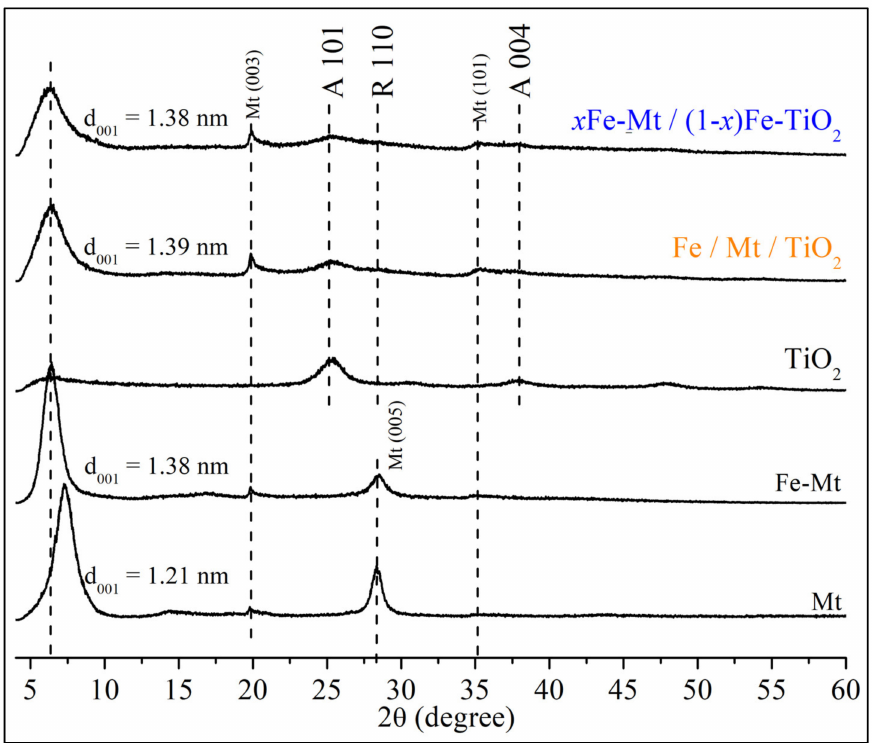
Figure 1. XRD patterns of original Mt, Fe-Mt synthesized at RT, TiO 2 , Fe/Mt/TiO 2 , and x Fe-Mt/(1 − x )Fe-TiO 2 synthesized at 70 ◦ C. The only single anatase phase of TiO 2 was presented for the pristine TiO 2 . For both Fe/Mt/TiO 2 and x Fe-Mt/(1 − x )Fe-TiO 2 , the 101 and 004 peaks at 25.4 and 37.9 ◦ (JCPDS No. 21–1272) of anatase phase were detected. Additionally, the 110 peak of rutile was formed at 28.3 ◦ . The representative 001, 003, and 101 reflection peaks of Mt in the composites were detected at 6.0–6.5, 19.8, and 35.2 ◦ , respectively [43]. The formation of TiO 2 in the composites by different synthetic temperatures was elucidated, and their XRD patterns were presented in Figure S2. Peak separation was utilized to further analyze the XRD patterns in more detail in Figure 2. The typical 101 diffraction of anatase at 25.4 ◦ and the 110 diffraction of rutile between 28.2–28.4 ◦ were well fitted. The parameters after peak fitting were listed in Table S1. The large full width at half-maximum (FWHM) values for anatase and rutile related to the broad peaks of all the samples suggested a low crystallinity of the TiO 2 phase on the Mt layers. The TiO 2 content in x Fe-Mt/(1 − x )Fe- TiO 2 at three synthesized temperatures was higher than in Fe/Mt/TiO 2 , and the Fe(III) in TiO 2 can improve the crystallization of the anatase phase. Increasing the temperature can improve the crystallization of anatase in Fe/Mt/TiO 2 but depress it in x Fe-Mt/(1 − x )Fe- TiO 2 from 80 ◦ C to 90 ◦ C. As proven by ICP analysis, only the location of Fe(III) can dominate the growth of TiO 2 phases on the aluminosilicate layers of Mt. For the following characterizations, the Fe/Mt/TiO 2 and x Fe-Mt/(1 − x )Fe-TiO 2 synthesized at 70 ◦ C were applied to compare with previous